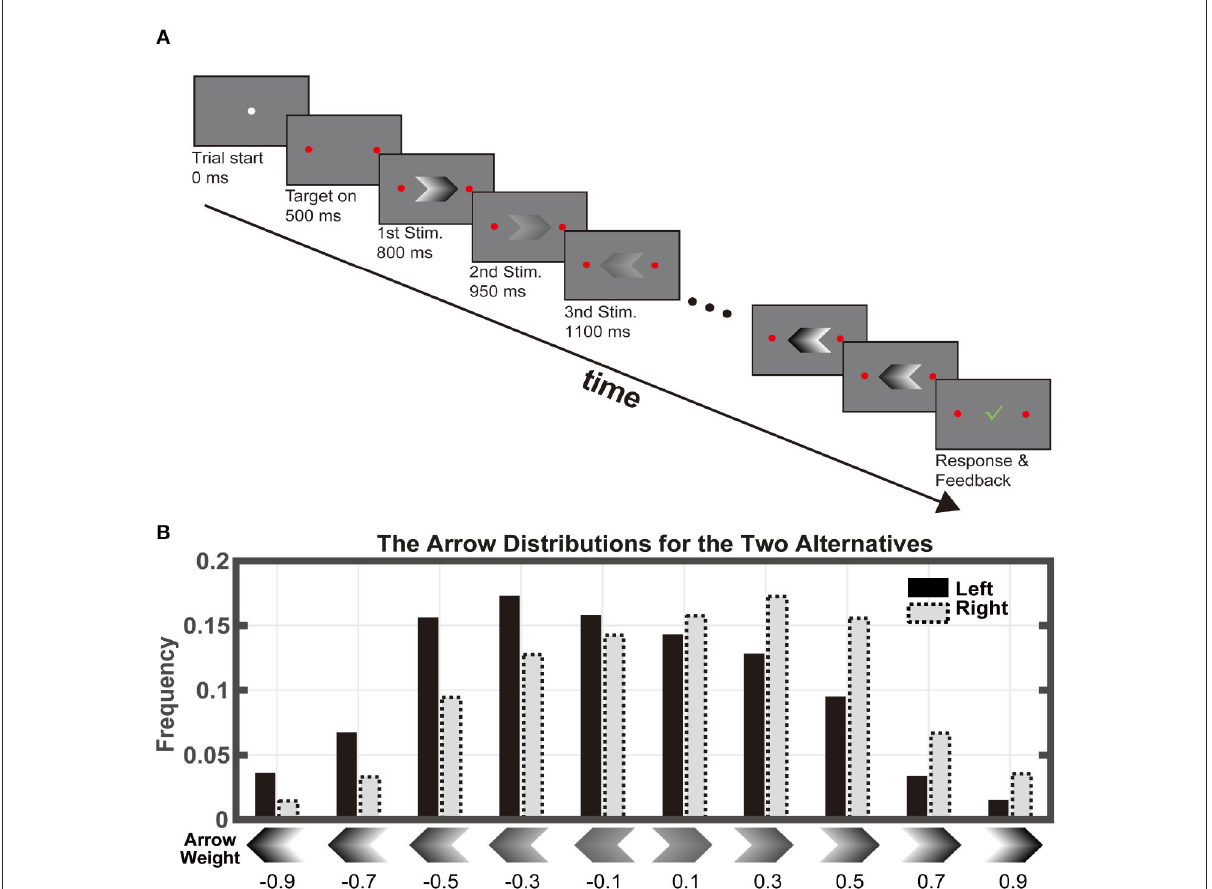
FIGURE1 Task paradigm. (A) Subjects viewed a series of arrow stimuli at different contrasts. Each stimulus was displayed for 150ms without inter-stimulus-interval. The maximal stimulus length was 100. The subjects indicated their choice by pressing one of the two buttons any time during the stimulus viewing period. (B) There were 10 stimulus types: two directions at 5 contrast levels. The stimuli were drawn from the distribution associated with the correct answer. The numbers below indicate the weight assigned to each stimulus, which equals the log-ratio between the probabilities of that the stimulus appears when the right target is the correct answer and when the left target is